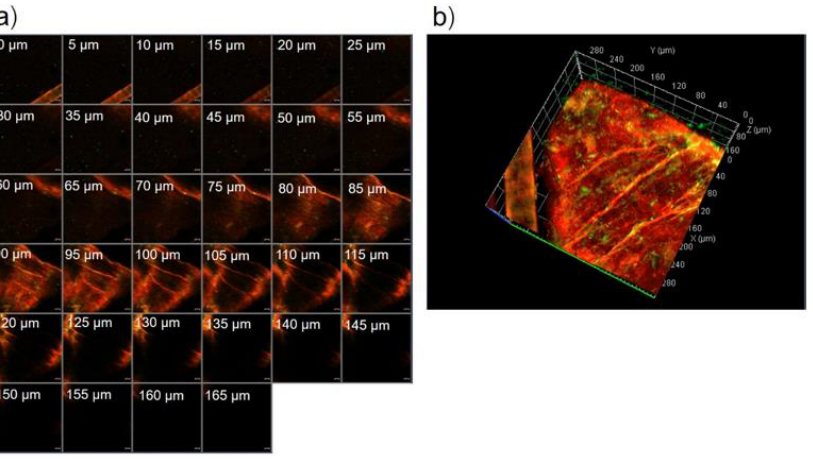
Figure 4. ( a ) The serial x-z plane images of the marked area in Figure 3c. The scale bar represents 20 μm, ( b ) intensity over the projection of z -axis in Figure 4a.